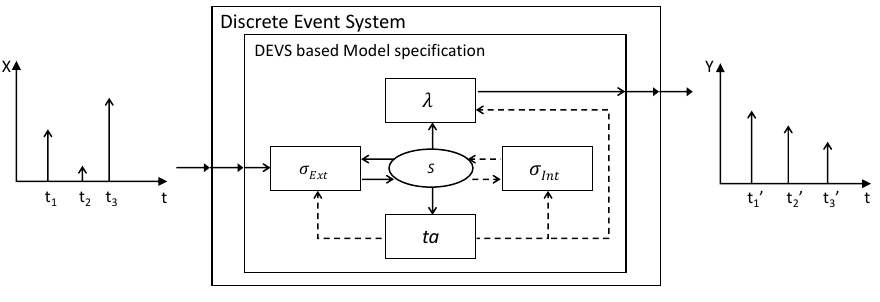
Figure 1. Specification of discrete event